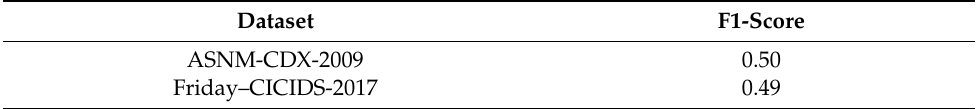
Table 8. Support Vector Machine results comparison for all